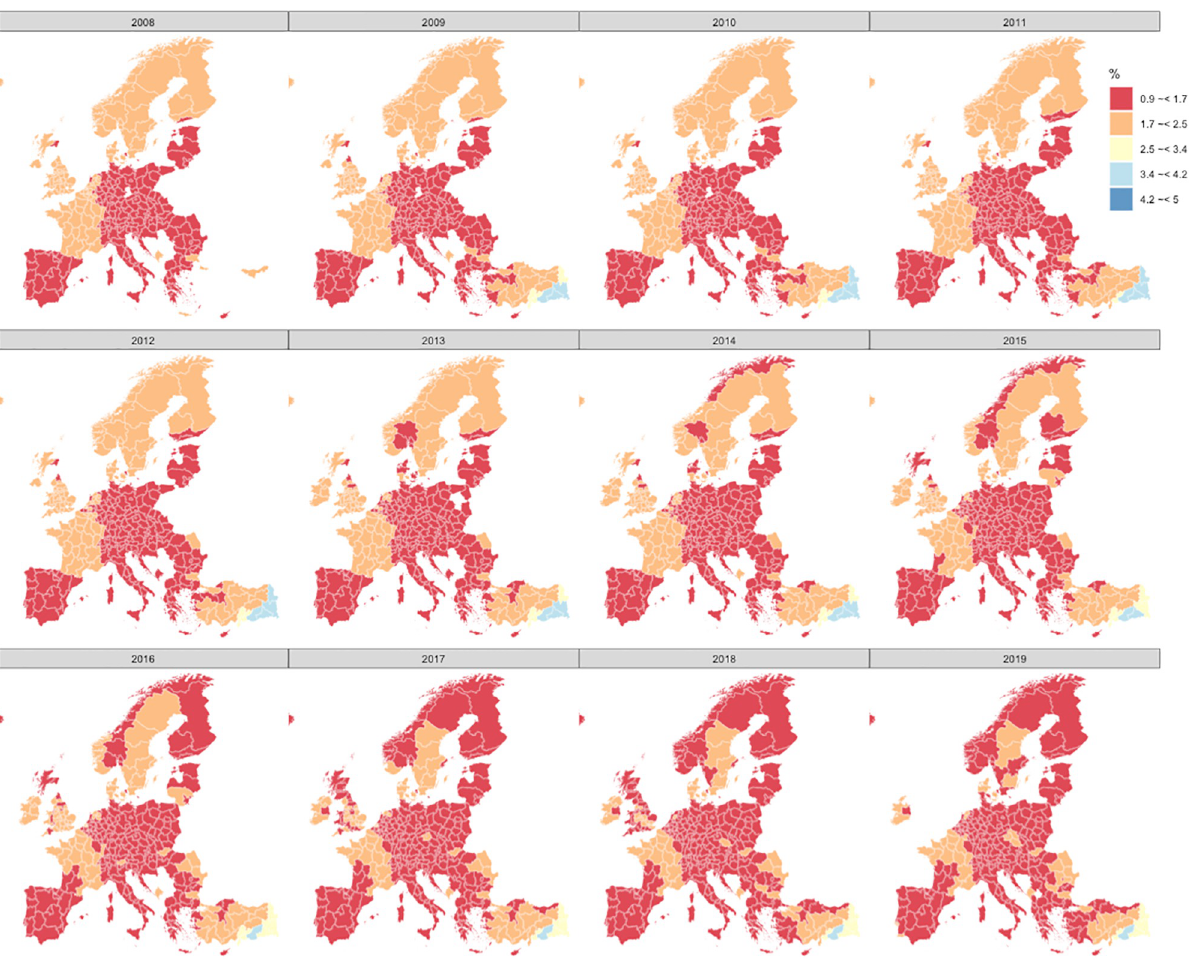
Fig 1. TFR at NUTS-2 level. Average number of live births per woman in Europe from 2008 to 2019. Source: Data from Eurostat and map built with the open source software R and package ‘Eurostat’.